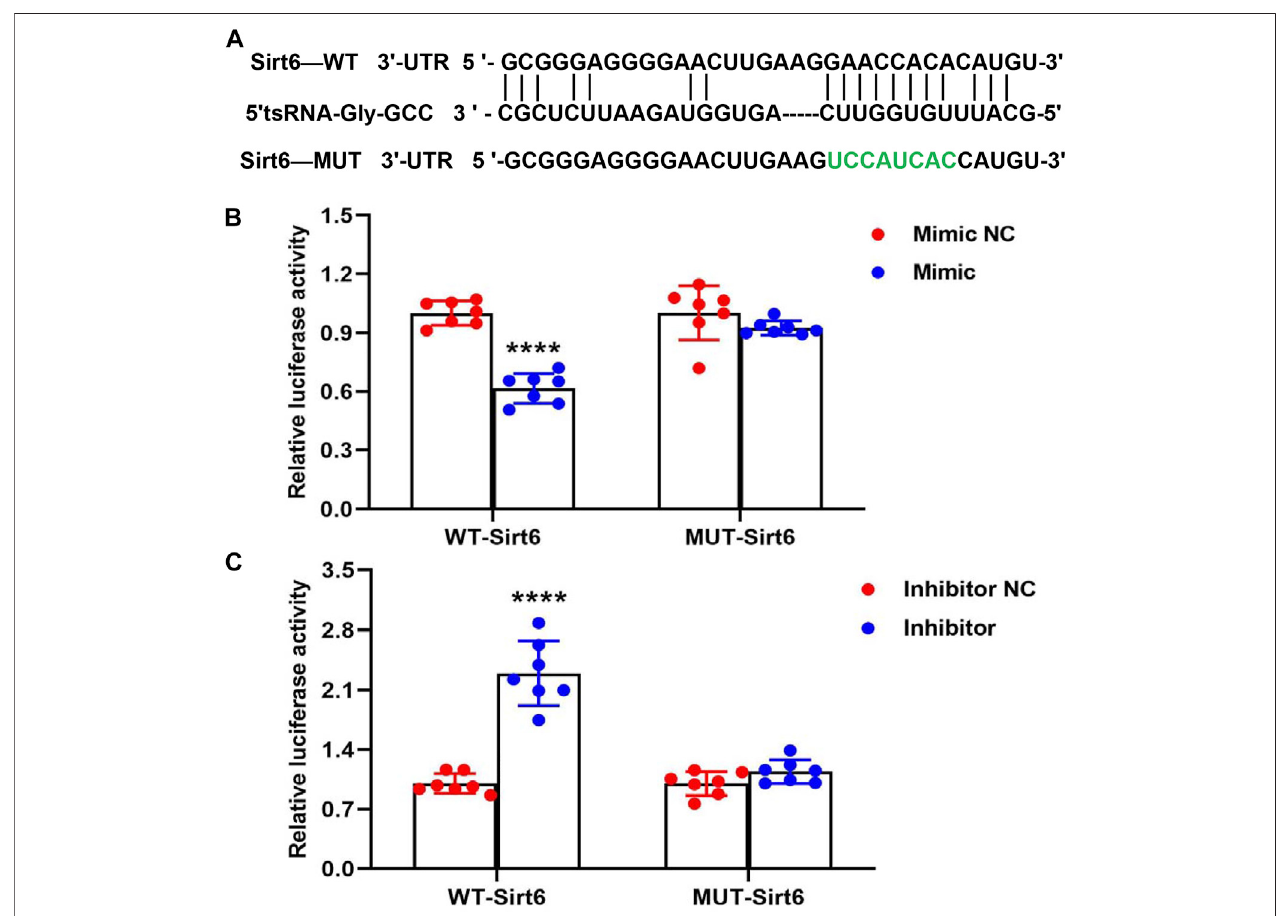
FIGURE5| 5 ′ tsRNA-Gly-GCC targets3 ′ UTRofSirt6mRNA. (A) Anillustrationoftheputativesiteof5 ′ tsRNA-Gly-GCCbindingwithinthe3 ′ UTRofSirt6predicted by bioinformatics software RNAhybrid, with green used to highlight those nucleotides mutated for a mutant version of this sequence. (B) Luciferase activity assay revealed that5 ′ tsRNA-Gly-GCC mimic transfection into Hepa1-6 cellsresulted ina 40%reduction in luciferase activity for constructs containing aWT but not amutated version of this 3 ′ UTR of Sirt6 binding site ( n = 7). (C) Luciferase activity assay revealed that 5 ′ tsRNA-Gly-GCC inhibitor transfection into Hepa1-6 cells signi fi cantly increased WT Sirt6 3 ′ UTR activity, while 5 ′ tsRNA-Gly-GCC inhibitor also had no signi fi cant effect on MUT Sirt6 3 ′ UTR ( n = 7). **** p <